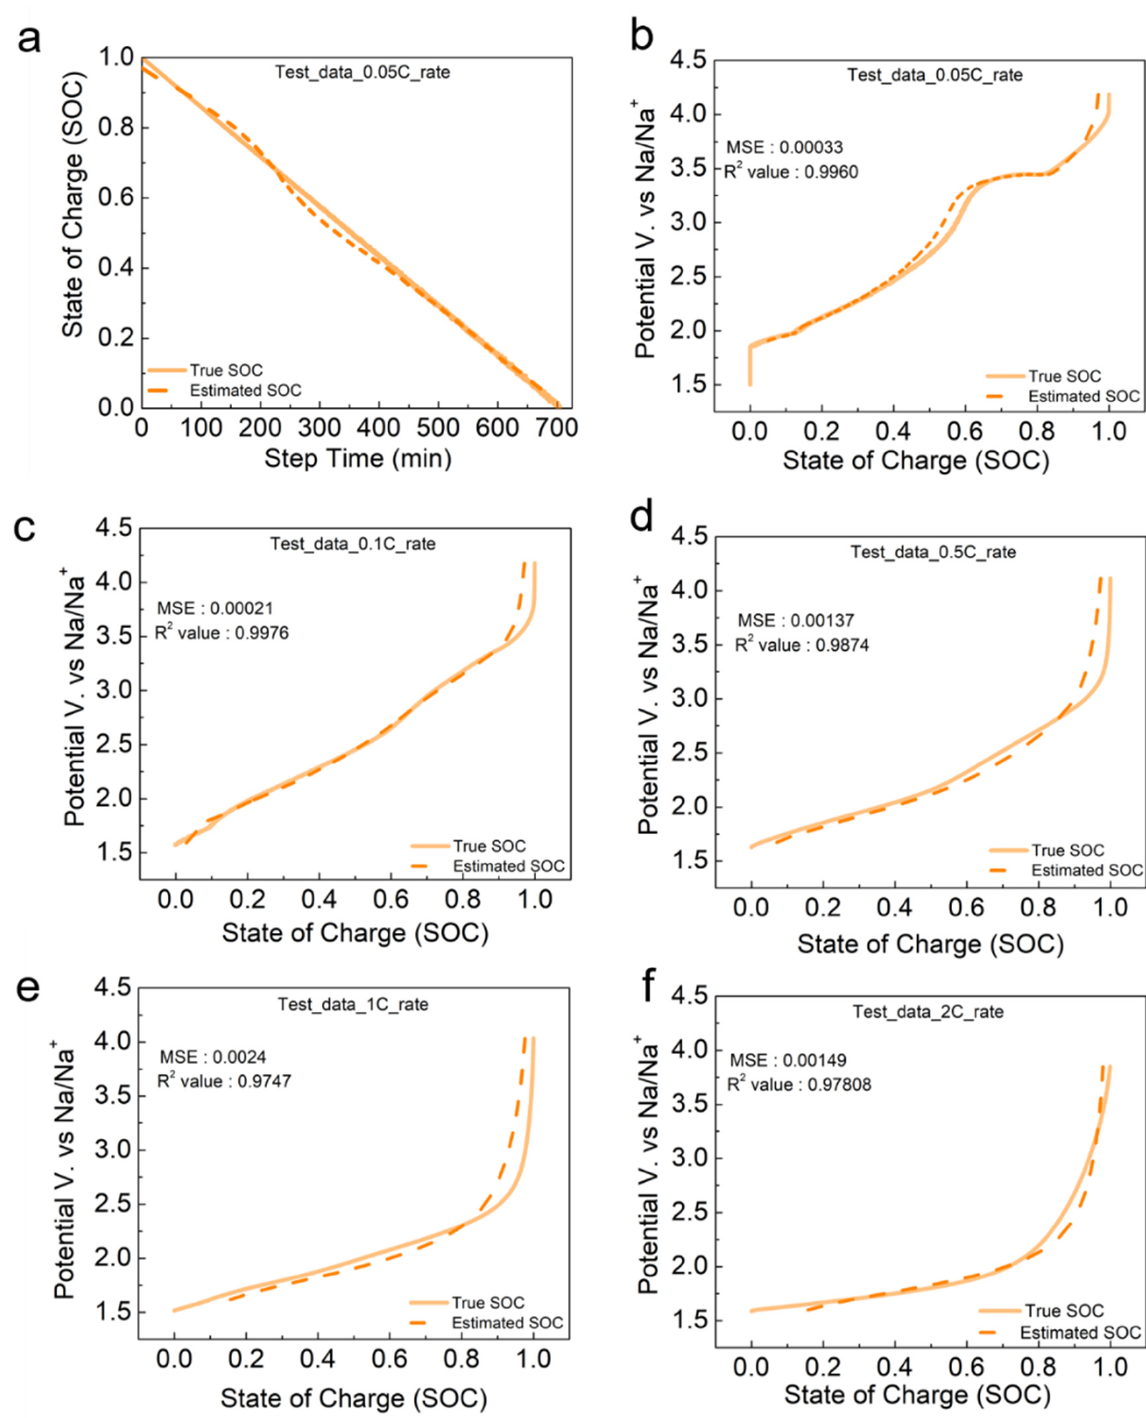
Figure 6. ( a ) Model performance is shown, using State of charge vs. time for the battery discharge data at a 0.05 C rate, by comparing the true and estimated values. However, for getting detailed information, the performance of the Feed forward neural network (FNN) model is shown, using voltage vs. State of charge graphs. Data used as battery discharged cycled between 1.5–4.2 V vs. Na/Na + at ( b ) 0.05 C, ( c ) 0.1 C, ( d ) 0.5 C, ( e ) 1 C, and ( f ) 2 C. The Mean square value and R 2 value are mentioned on each graph.